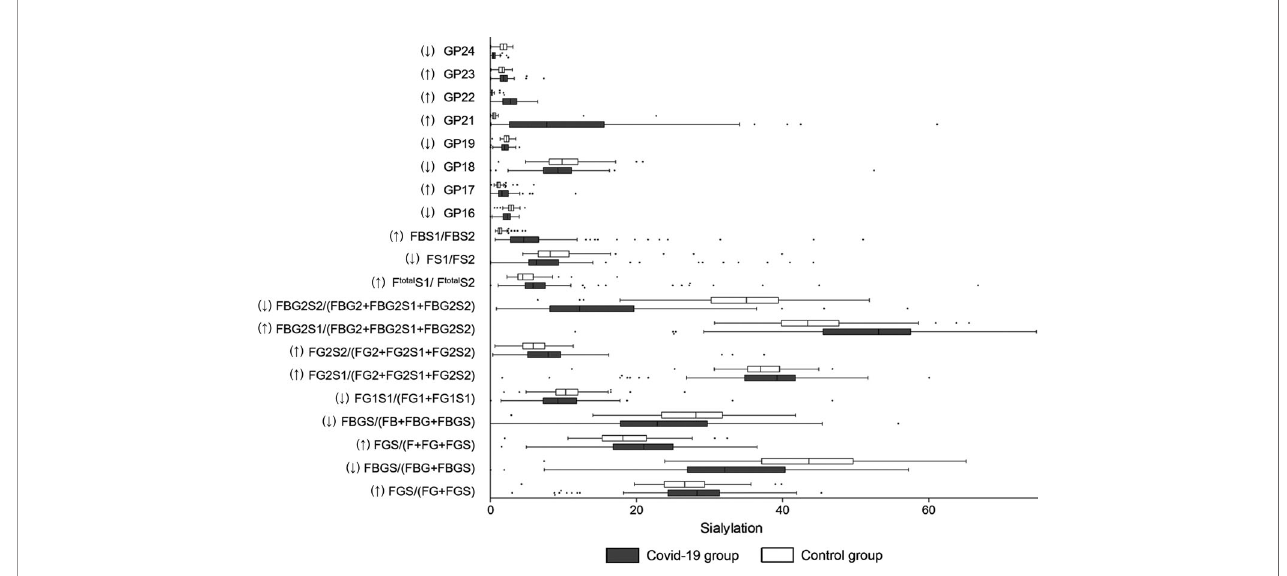
FIGURE 2 | Sialylation on IgG in COVID-19 patients and the healthy controls. B, bisecting N-acetylglucosamine (GlcNAc); F, fucose; G, galactose; GP, glycan peak; S, Sialic acid; ↑ , the glycan in COVID-19 group is signi fi cantly higher than that in the controls; ↓ , the glycan in COVID-19 group is signi fi cantly lower than that in the